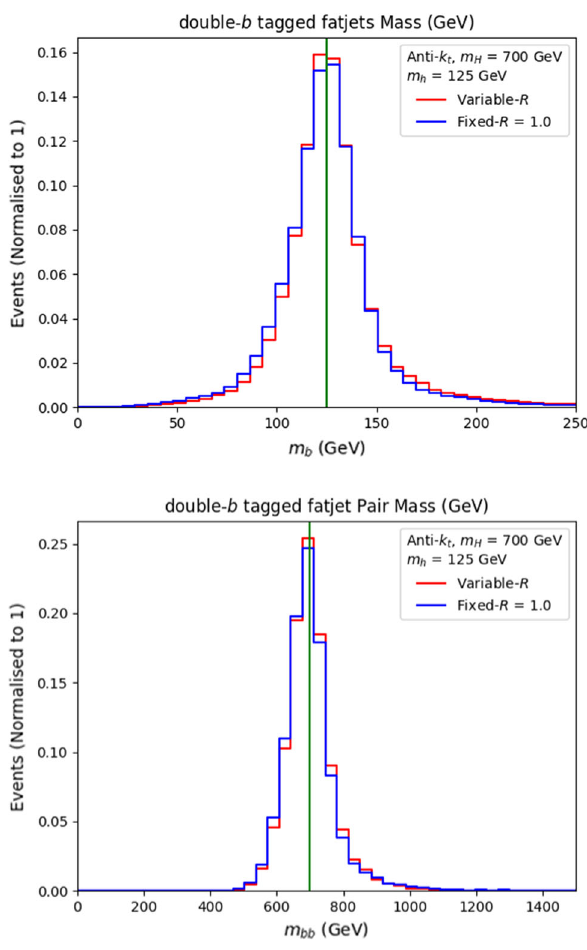
Fig. 6 Upper panel: the double b -tagged fat jets invariant mass m h for our BP. Lower panel: the two double b -tagged fat jets invariant mass m H for our BP